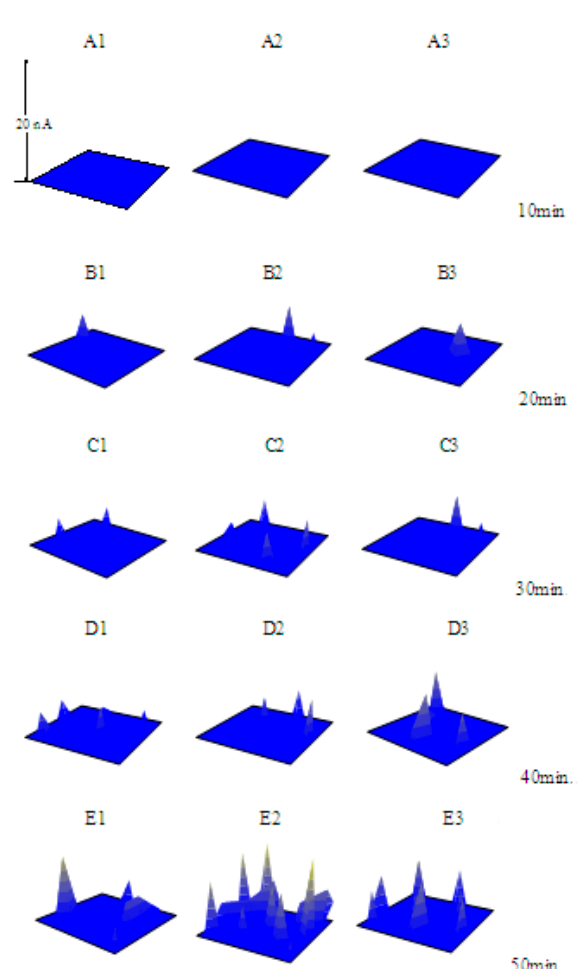
Figure 9. The SECM images of the X70 carbon steel electrodes polarized at − 0.150 V ( E OCP = − 0.400 V) in 0.10 mol/L NaCl + c a mol/L Na 3 PO 4 + c b mol/L NaNO 2 solutions ( A1 – E1 ) c a = 0.030, c b = 0.010; ( A2 – E2 ) c a = 0.020, c b = 0.020; ( A3 – E3 ) c a = 0.010, c b = 0.030.